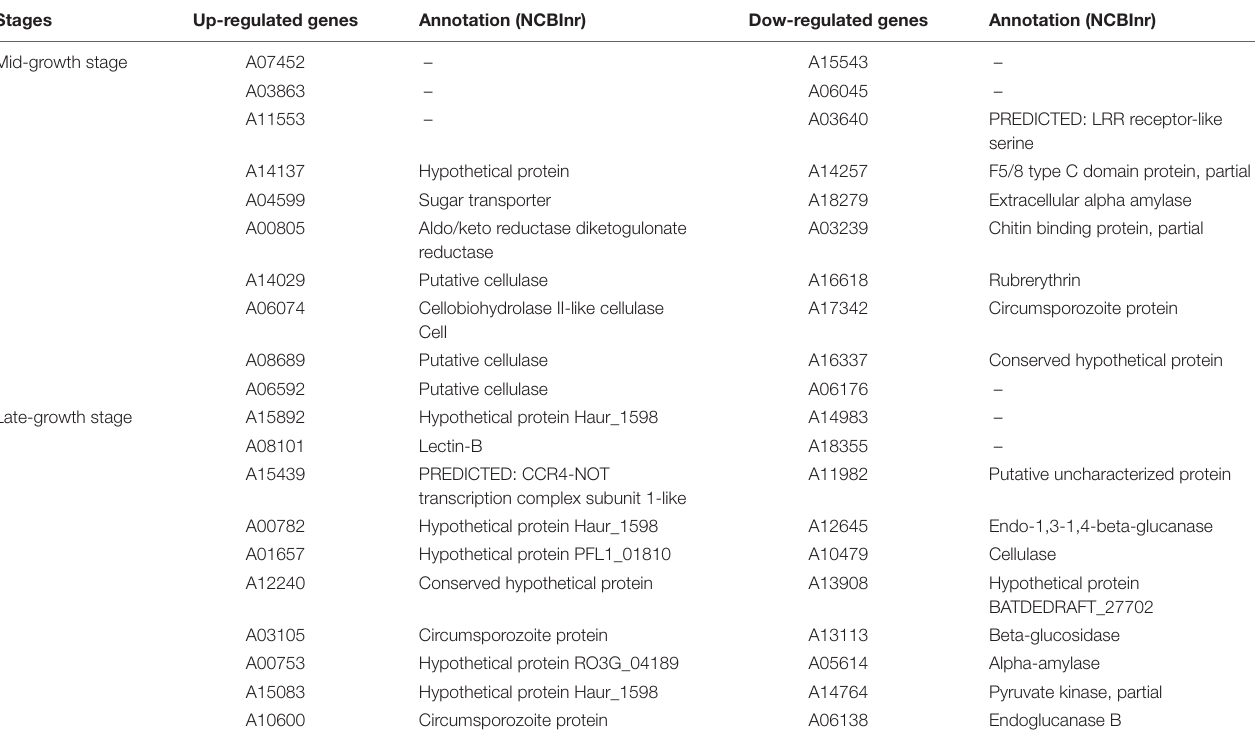
TABLE 3 | The top 10 up-/down-regulated genes of anaerobic fungus Pecoramyces sp. F1 at mid- and late-growth